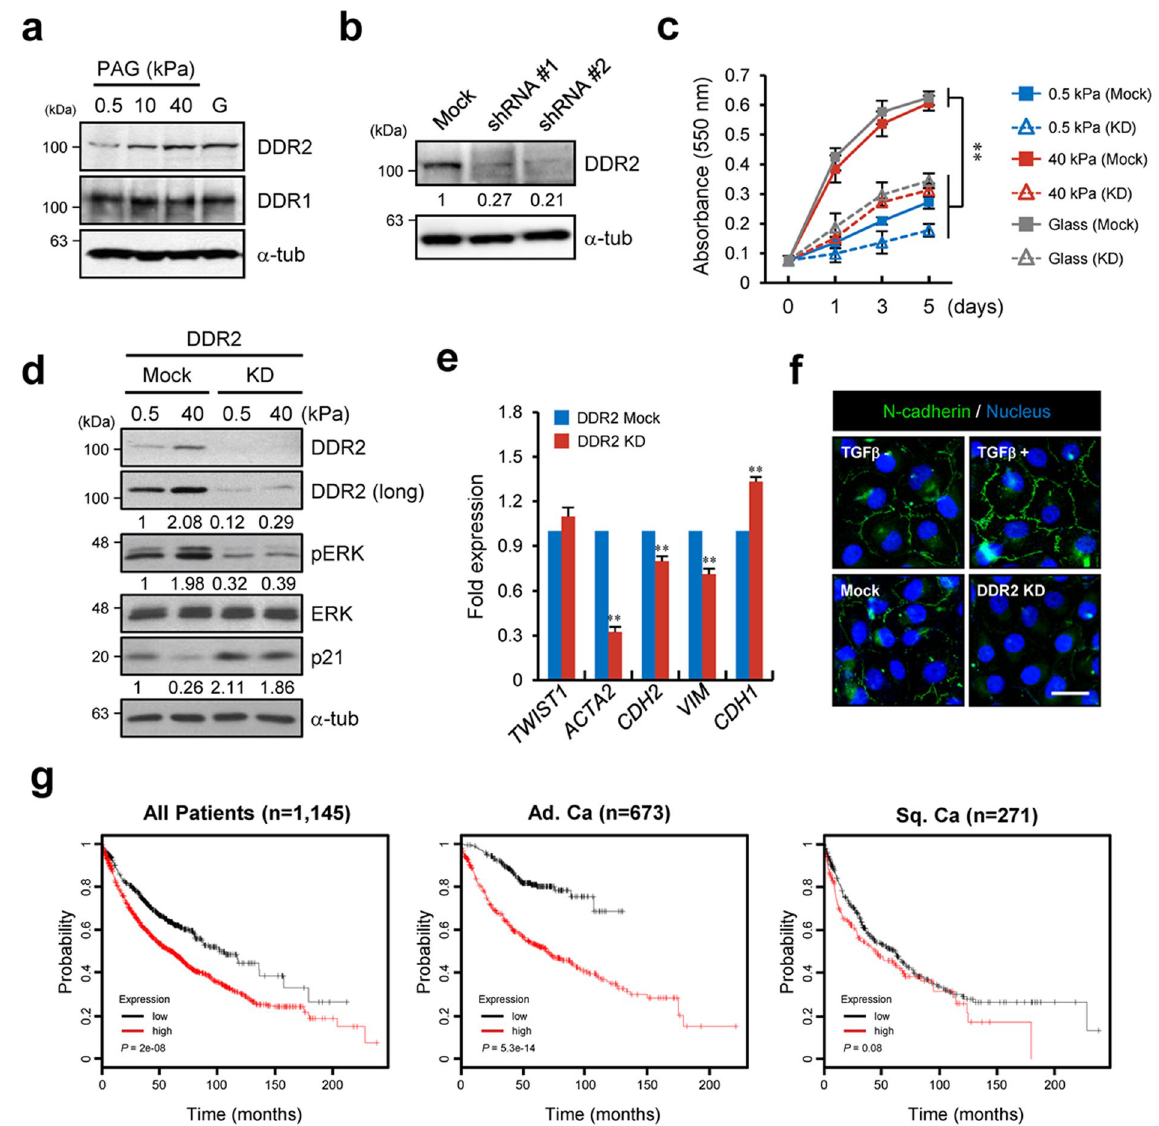
Figure 2. DDR2 is a key player in matrix stiffness–induced EMT. ( a ) Western blot analysis of DDR1 and DDR2 in H1299 cells incubated on a PAG with the indicated stiffness. ( b ) Western blot analysis of DDR2 in H1299 cells expressing mock or anti-DDR2 shRNA. ( c ) Quantification of proliferation of H1299 cells expressing mock or anti-DDR2 shRNA with indicated stiffness and duration. Data represent the mean of three independent experiments ± SEM. ** P < 0.01. ( d ) Western blot analysis of DDR2, pERK, ERK, and p21 in H1299 cells expressing mock or anti-DDR2 shRNA under the indicated conditions. ( e ) qRT-PCR analysis of expression of TWIST1 , ACTA2 , CDH2 , VIM , and CDH1 in H1299 cells expressing mock or anti-DDR2 shRNA. Data represent the mean of three independent experiments ± SEM. ** P < 0.01. ( f ) Immunostaining of N-cadherin and the nucleus in H1299 cells expressing mock or anti-DDR2 shRNA. Mock shRNA–expressing H1299 cells in the presence of 10 ng ml − 1 TGF- β served as positive controls. ( g ) Kaplan–Meier curves of overall survival among patients with lung cancer, including lung adenocarcinoma and squamous cell lung